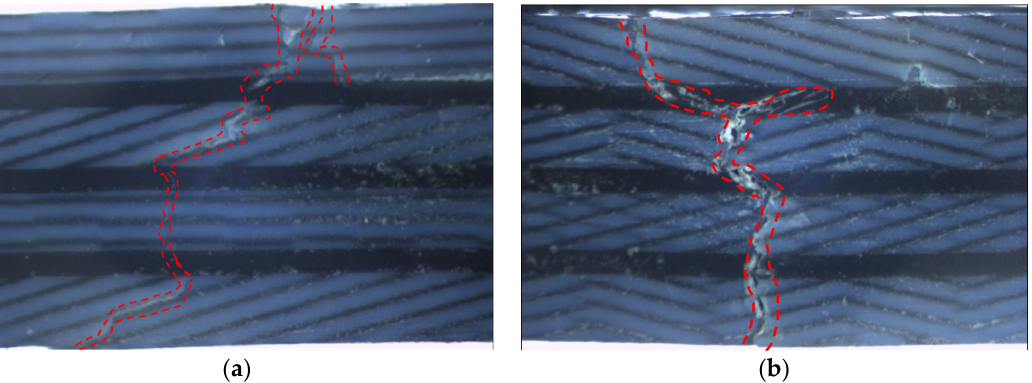
Figure 17. Crack propagation path in cross-section of Bio-S composite plate: ( a ) (30°/90°/30°/90°); ( b ) (0°/30°/0°/30°).